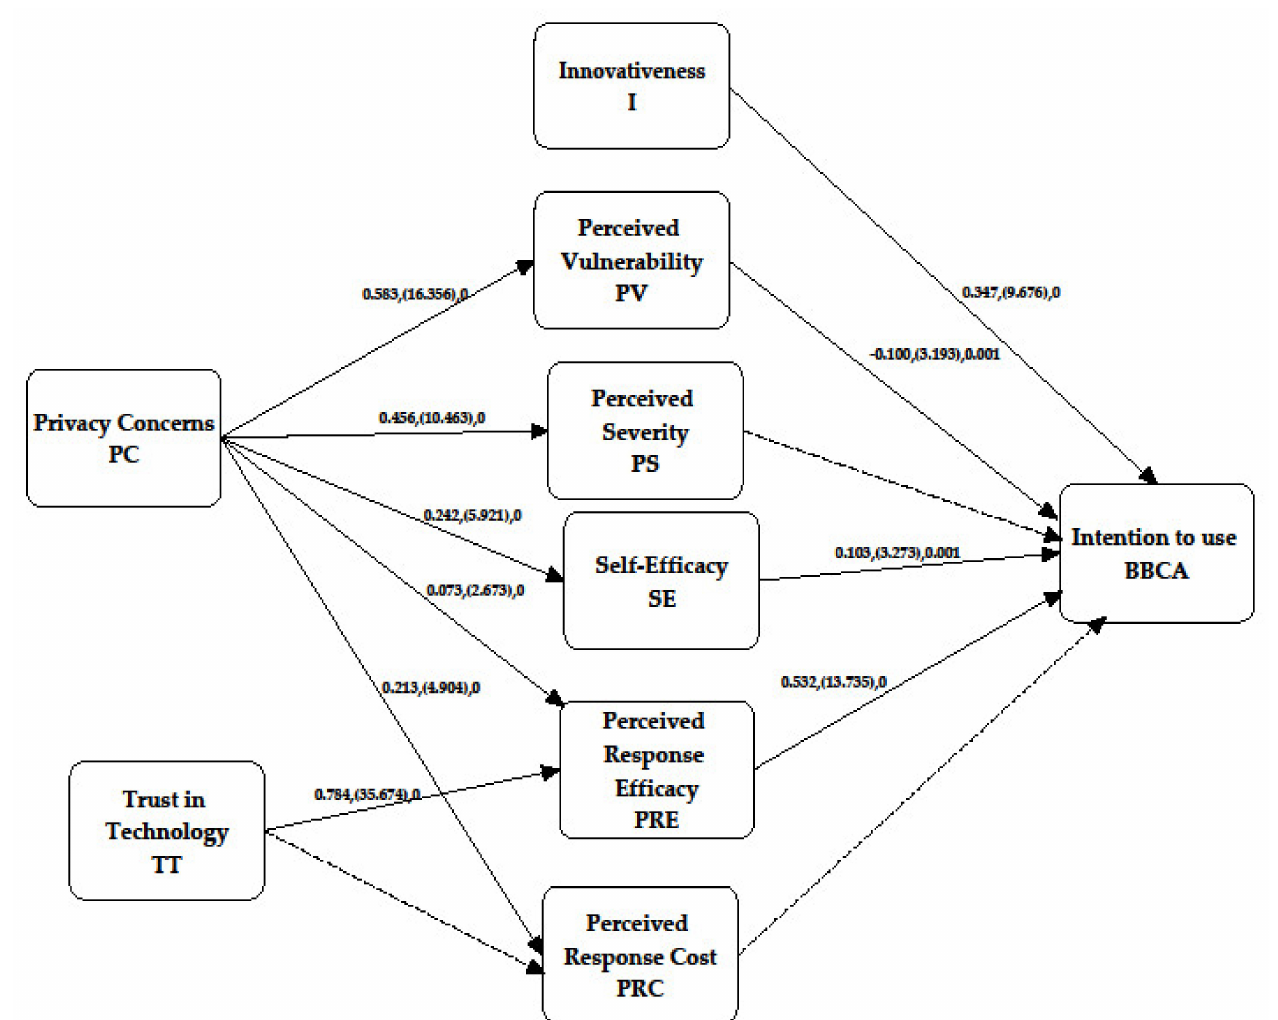
Figure 6. Structural model result. Note: in figure presented direct effects β , (t-value) and p -value. The dotted lines are